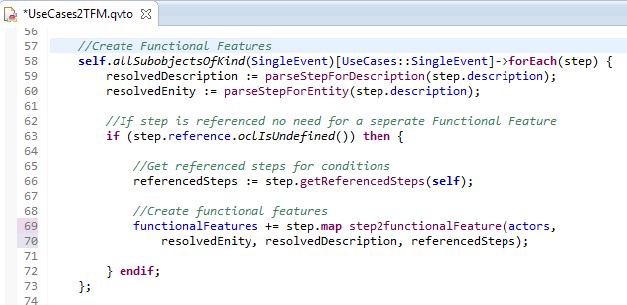
Fig. 5. Model transformation in QVTo. This is a small snippet from the entire model transformation code, which deals with generating functional